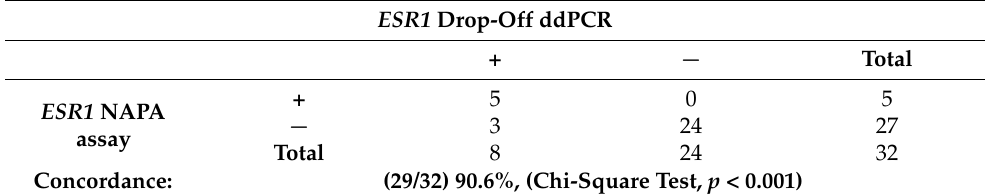
Table 2. Comparison between the developed ESR1 NAPA assay and the drop-off ddPCR for 32 identical cfDNA